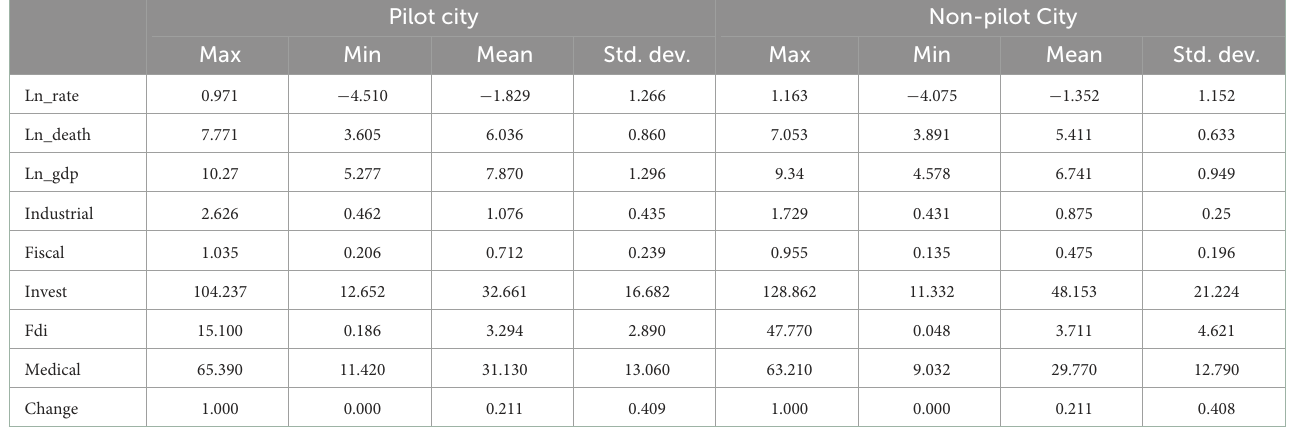
TABLE 1 Descriptive statistics of the variables.